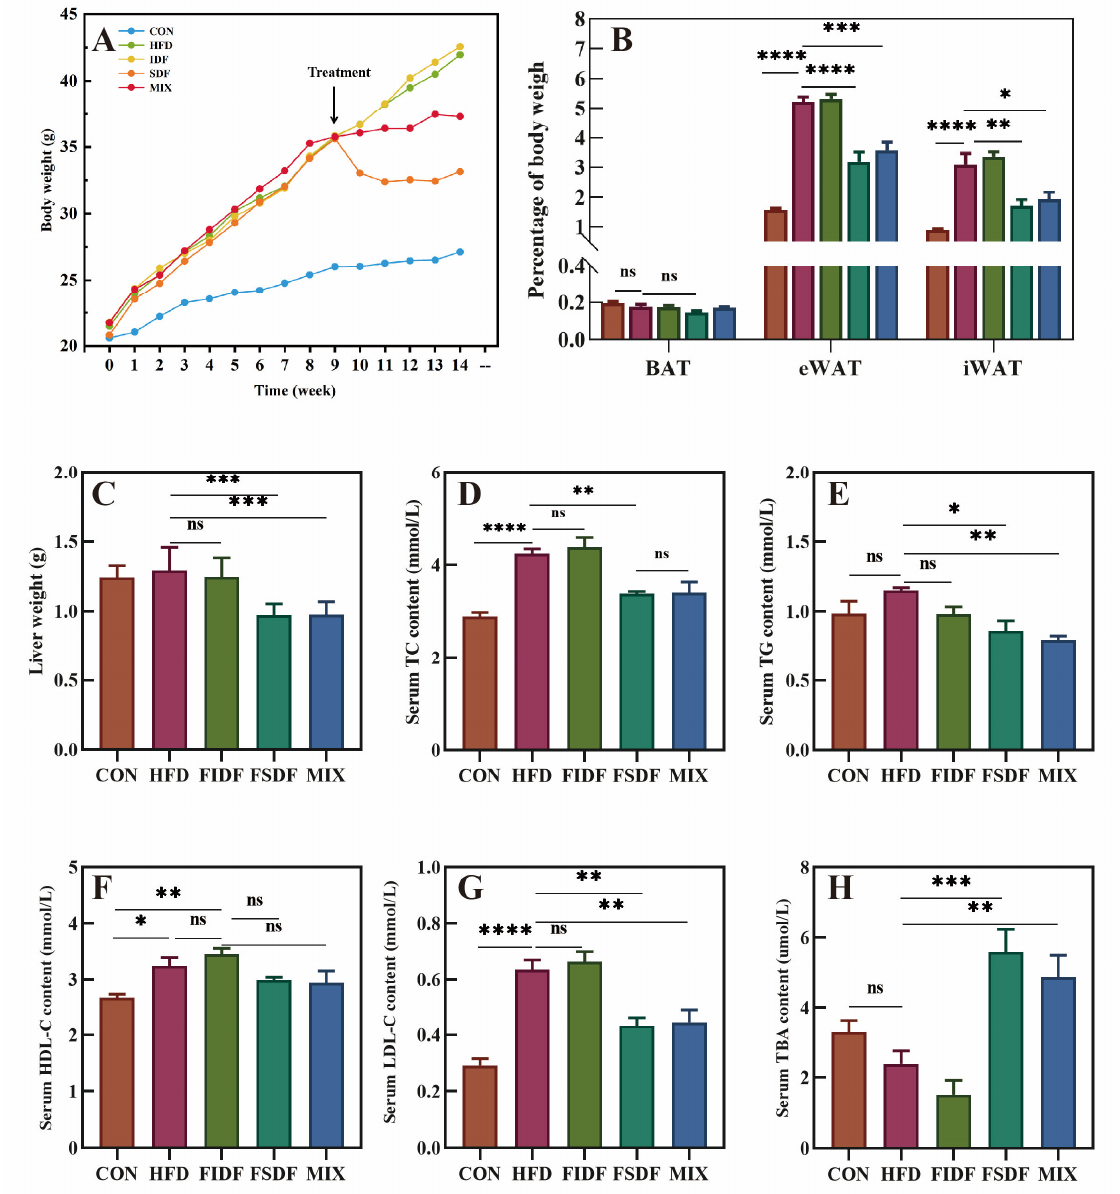
Figure 2. Effects of FIDF and FSDF on obesity symptoms and plasma biochemical parameters. ( A ) Body weight. ( B ) Percentage of BAT, eWAT, and iWAT to body weight. ( C ) Liver weight. ( D – H ) Serum TC, TG, HDL-C, LDL-C, and TBA contents, respectively. CON, control group; HFD, high-fat diet group; FIDF, group supplemented with FIDF alone; FSDF, group supplemented with FSDF alone; MIX, group supplemented with FIDF and FSDF together. Data are expressed as mean ± SEM ( n = 6). * p < 0.05; ** p < 0.01; *** p < 0.0001; **** p < 0.0001; ns, not significant.